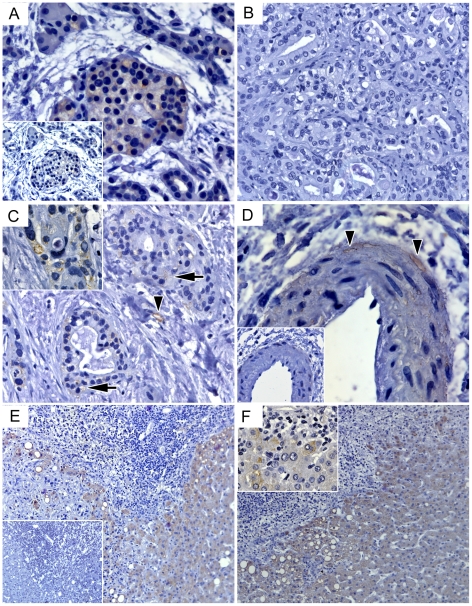
Ectopic sources of Epo in tissues of patients with pancreatic diseases.(A) Remnants of Epo-producing islets in degrading CP-parenchyma. (B) Epo-negativity of tumor cells in primary pancreatic lesion, except for sporadic focal staining observed in intracellular vacuoles of tumor cells (C, arrows and inset). Peripheral capillaries (C, arrowheads) and vasa vasorum (D, arrowheads) of bigger vessels frequently demonstrated Epo positivity in PDAC and CP. (E, F) In liver, cytoplasmic staining of hepatocytes was strong in areas directly bordering Epo-negative metastatic tumor cells and inflammatory infiltrates, but faded away distally, thus pointing to the spatially regulated de novo synthesis and creation of multiple Epo-rich niches. Insets in A, D and E depict negative (isotype IgG) controls; insets in C and F show high-magnification (×630) images of staining patterns in intracellular vacuoles of tumor cells and cytoplasm in hepatocytes.